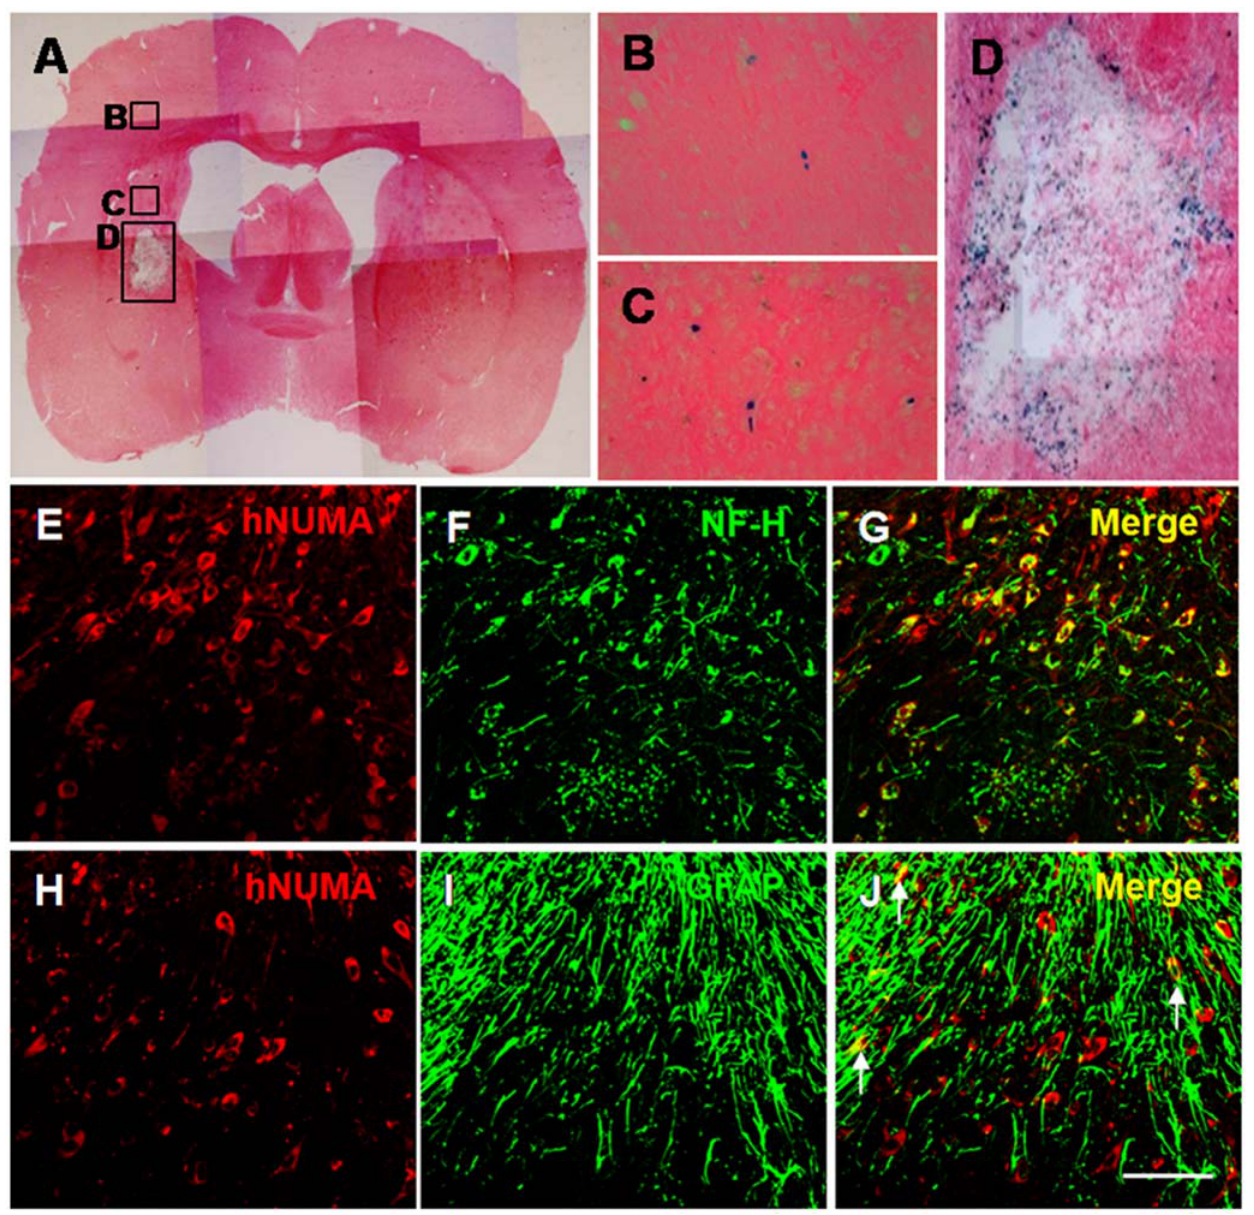
Figure 4. LacZ (beta-galactosidase)-labeled F3.Akt1 human NSCs in intracerebral hemorrhage (ICH) mouse brain at 2 weeks post- transplantation. A: One week after an ICH lesion (an intrastriatal injection of collagenase), LacZ -labeled F3.Akt1 NSCs were transplanted into the cortex overlying the ICH lesion. Two weeks post-transplantation, LacZ-positive F3.Akt1 NSCs were found to migrate extensively into the hemorrhage core and surrounding brain sites. Bar indicates 50 m m. B–D: Higher magnification of indicated areas. Bar indicates 20 m m. E–G: Double immunofluorescent staining of engrafted F3.Akt1 human NSCs in ICH mouse brain 8 weeks post-transplantation. F3.Akt1 NSCs in the lesion sites are found to differentiate into neurons as shown by double staining of human nuclear matrix antigen (hNuMA) and neurofilament protein (NF-H, a neuron specific marker). H–J: F3.Akt1 human NSCs in the lesion sites are found to differentiate into astrocytes (arrows) as shown by double staining of human nuclear matrix antigen (hNuMA) and glial fibrillary acidic protein (GFAP, an astrocyte specific marker). Bar indicates 20 m